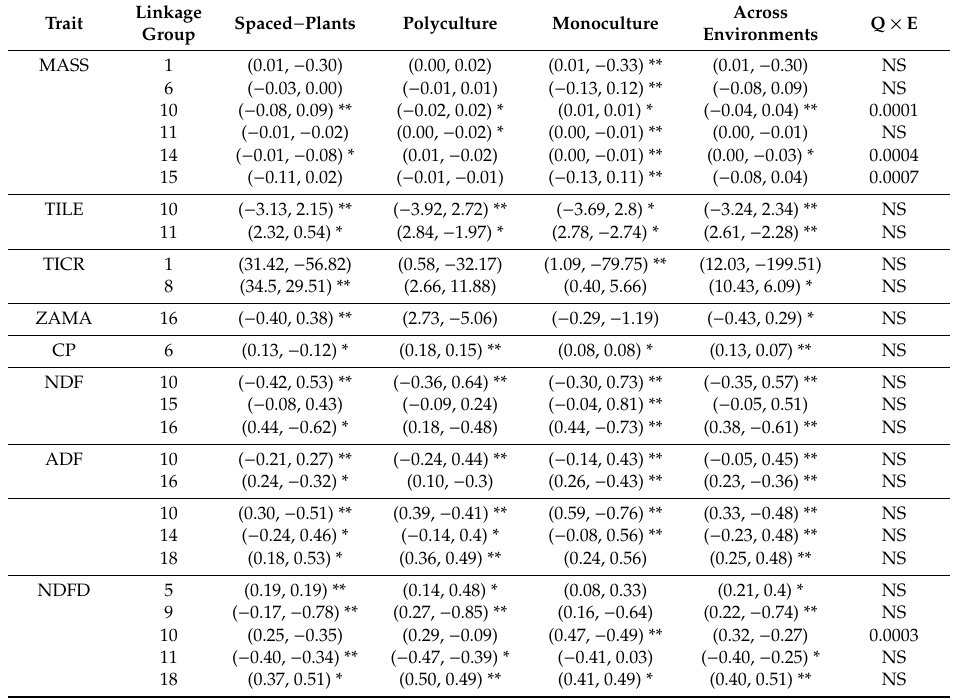
Table A3. Significance of QTL by environment interactions (Q × E), and estimates of QTL e ff ects ( α , γ ) as a percentage of population mean where α is di ff erence between QTL alleles of the M26 parent and γ is di ff erence between QTL alleles of the M35 parent. QTL were identified for 192 clonally replicated, full-sib progeny (genets) of the M26 × M35 intermediate wheatgrass mapping population evaluated